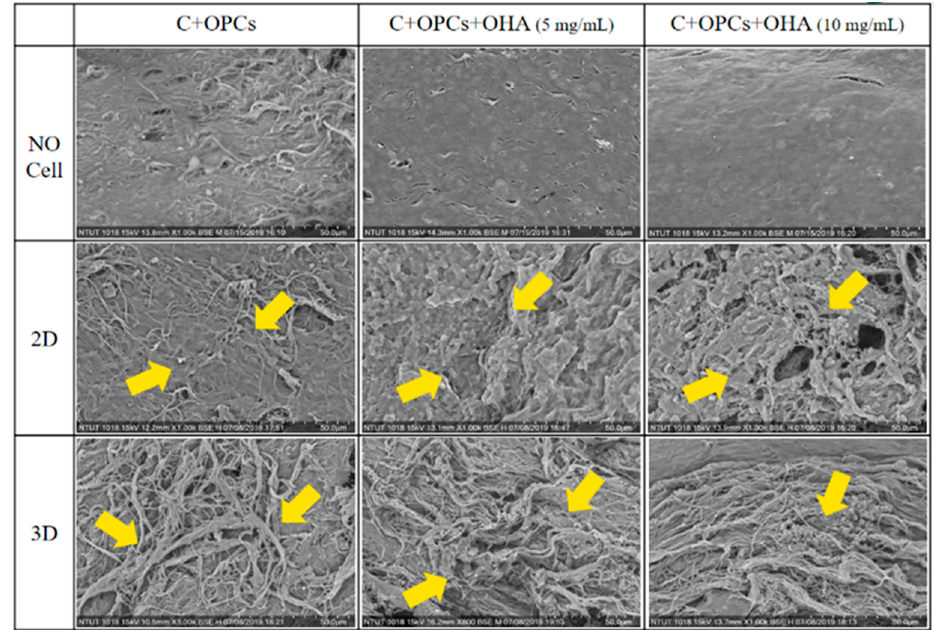
Figure 11. SEM of morphology of rBMSCs (yellow arrows) spread on the surface of a 2D membrane and 3D collagen scaffolds.